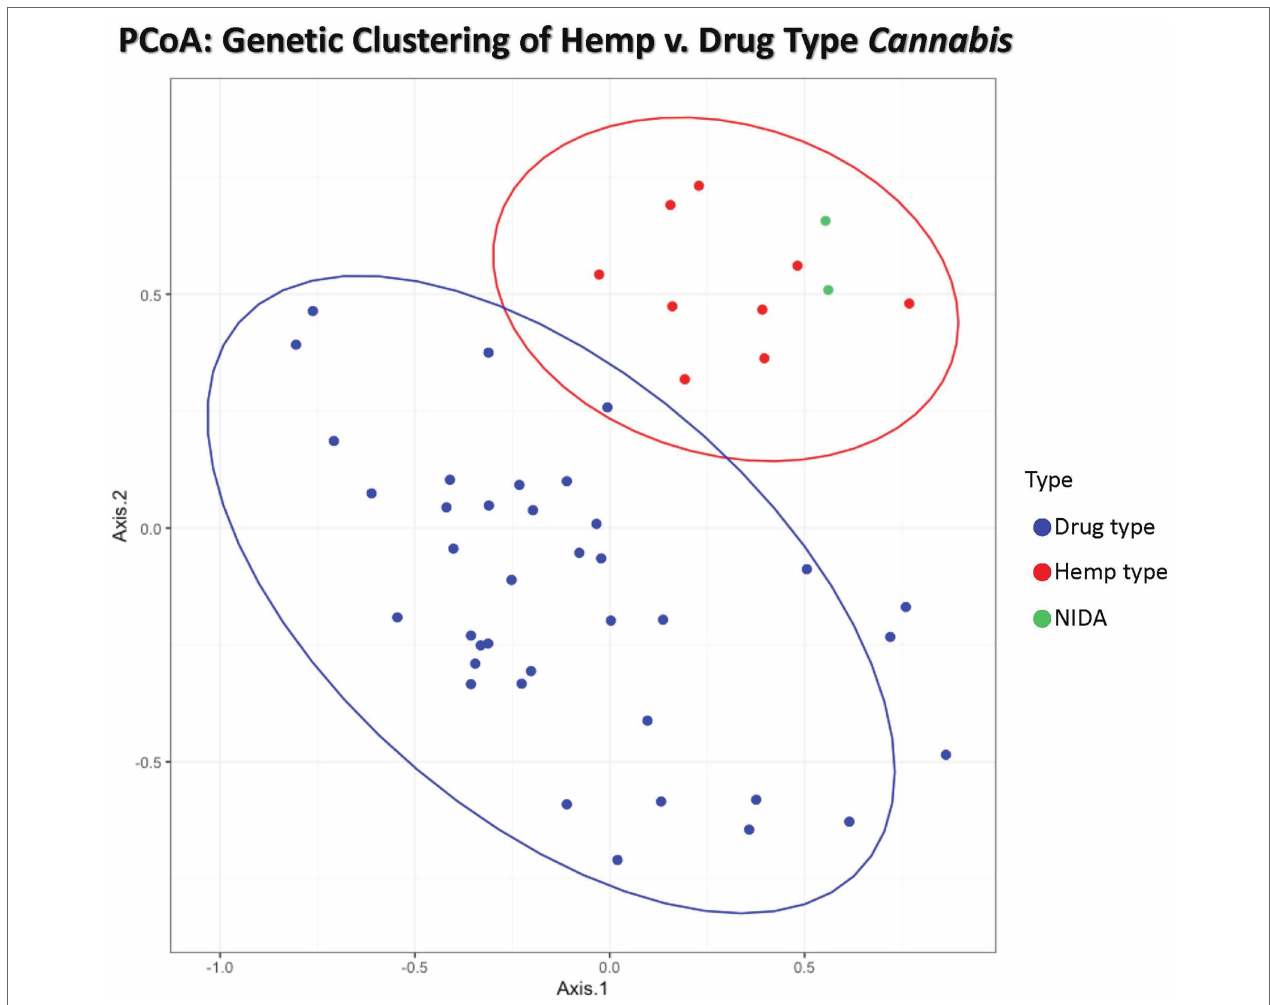
FIGURE 1 | Principal coordinates analysis of genetic distance among samples. Samples clustering together are more closely related. The ellipses represent 95% confidence intervals for each group (Cultivated hemp = orange, Wild hemp = yellow, NIDA = blue, High CBD = pink, Sativa = red, Hybrid = green, Indica = purple). Approximately 24% of the genetic variation in these groups is shown (Axis 1 = 13.02% and Axis 2 =